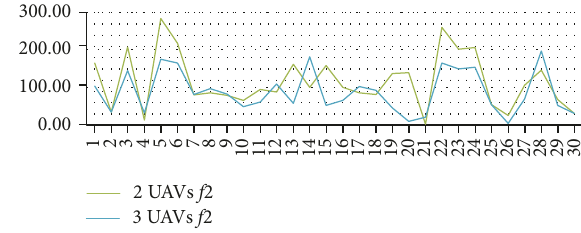
Figure 16: La Palma attraction path planning results for distributed